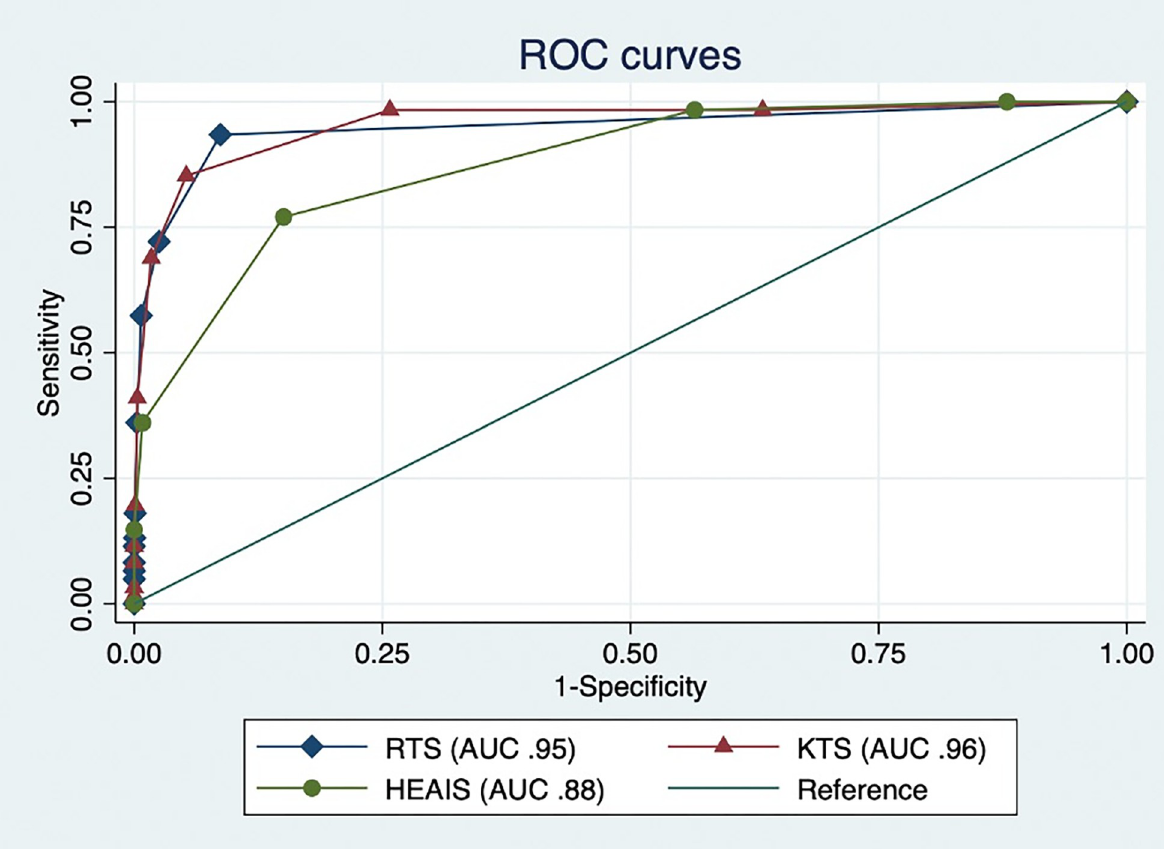
Fig 1. Receiver operating characteristic curves. Key: ROC = Receiver operating characteristic; AUC = Area under the ROC curve; 95% CI = 95% confidence interval; n = number of patients; HEAIS = Highest estimated abbreviated injury scale; RTS = Revised Trauma Score; KTS = Kampala Trauma